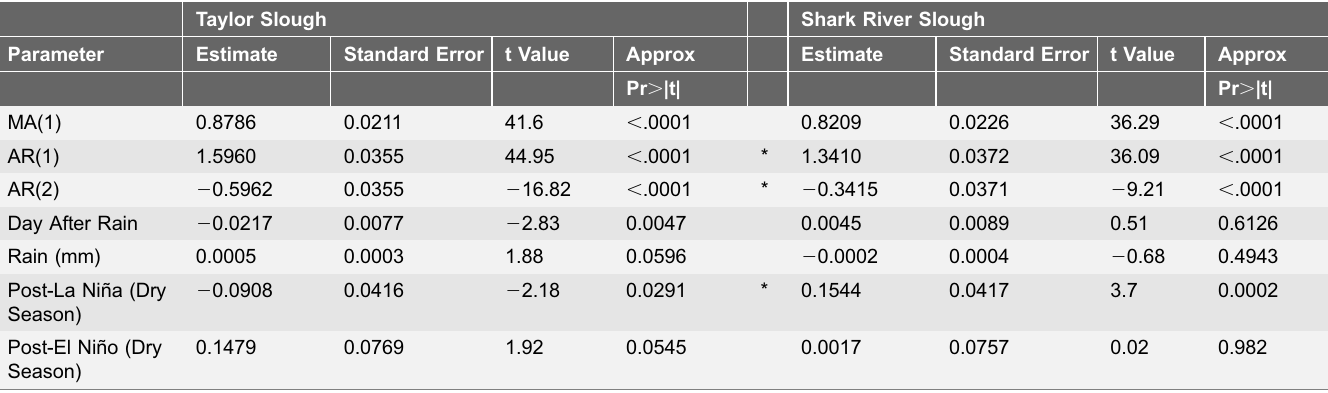
Table 5. Parameter estimates from ARIMA models of daily R eco by